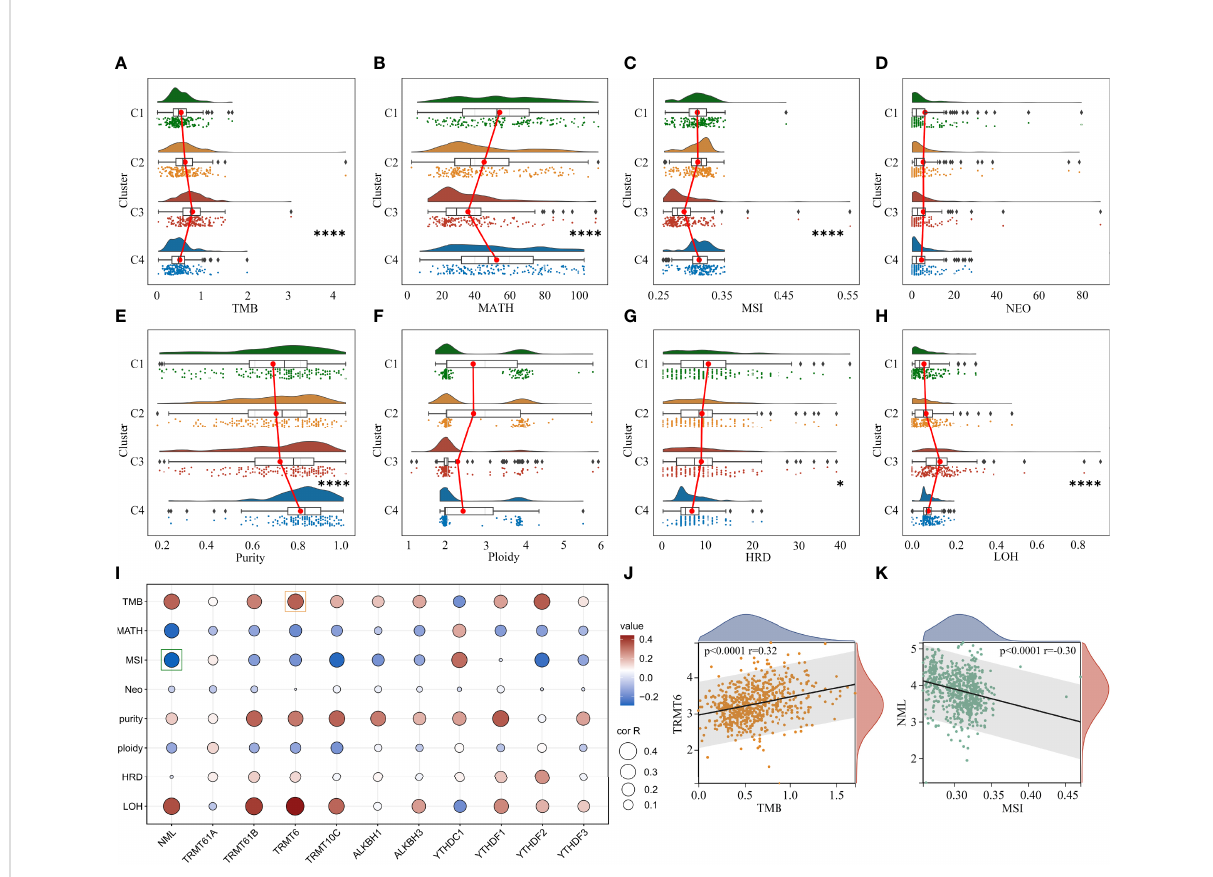
FIGURE 5 Analysis of genomic heterogeneity in glioma. (A – H) Differences in TMB, MATH, MSI, NEO, Purity, Ploidy, HRD and LOH between clusters. (I) Correlation between m 1 A regulators and genomic heterogeneity. (J) Representative scatter plot showing the correlation between TRMT6 and TMB. (K) Representative scatter plot showing the correlation between NML and MSI. *, P < 0.05; ****, P <